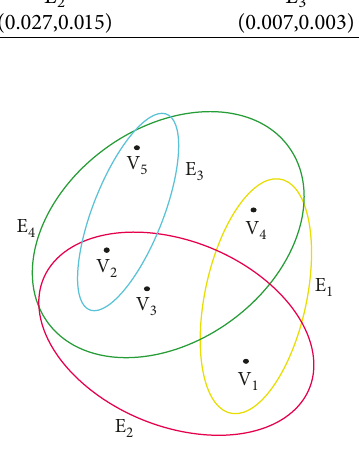
Figure 11: IFGH H with only end nodes.